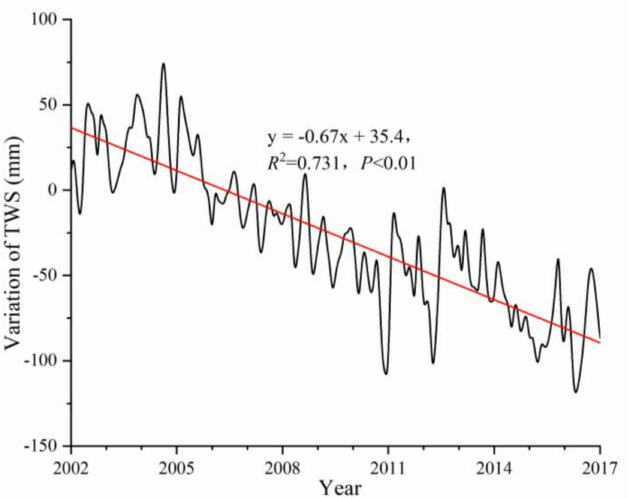
Figure 12. Changes of terrestrial water storage in the mountain area of Yongding River from 2002 to